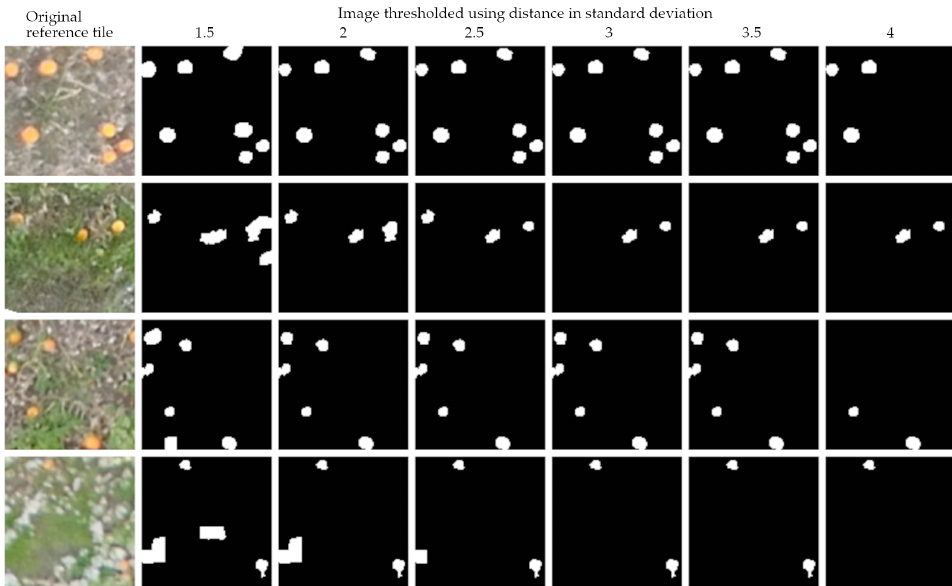
Figure 7. Results of superpixel segmentation for different values of standard deviation multiplicator— threshold_r